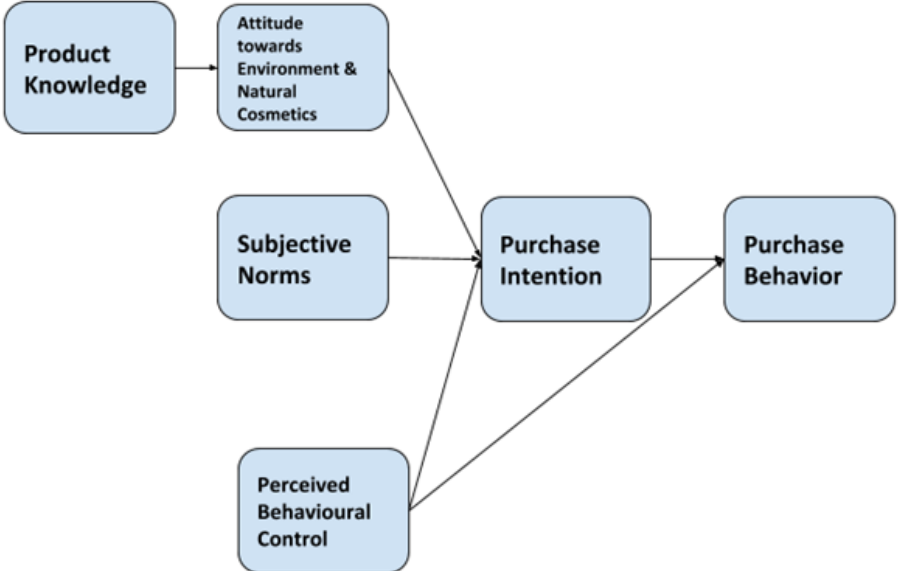
Figure 1. The conceptual model based on the theory of planned